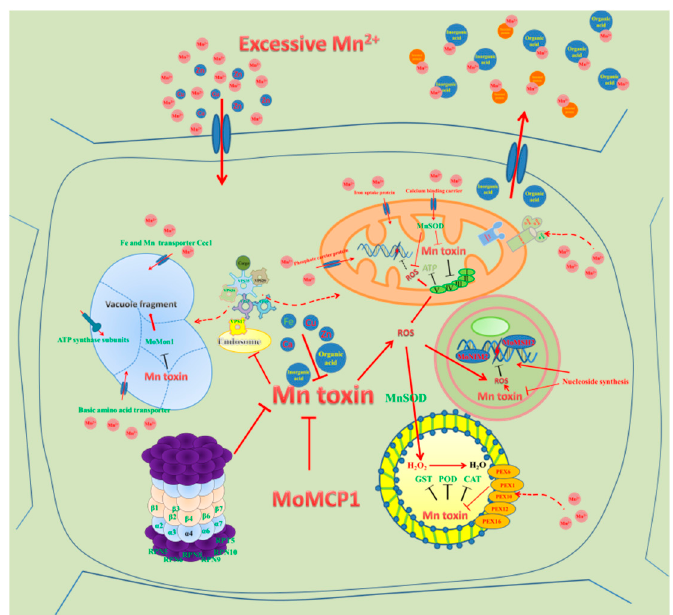
Figure 9. The putative gene network about MoMCP1 alleviating Mn 2+ toxin in M. oryzae . The colored arrows mean the induced or promoted reactions. The dotted arrows mean the putative associations. The “T” bars mean the inhibitory reactions.